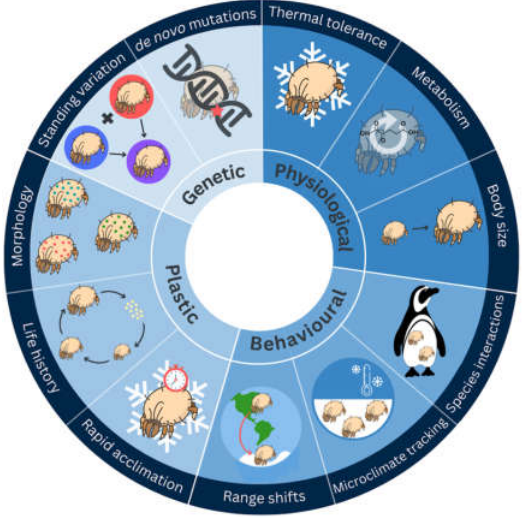
Figure 2. The potential physiological, behavioural, plastic, and genetic responses associated with surviving life at the poles. For simplicity, we depict discrete categories, though responses may fall into >1 category.